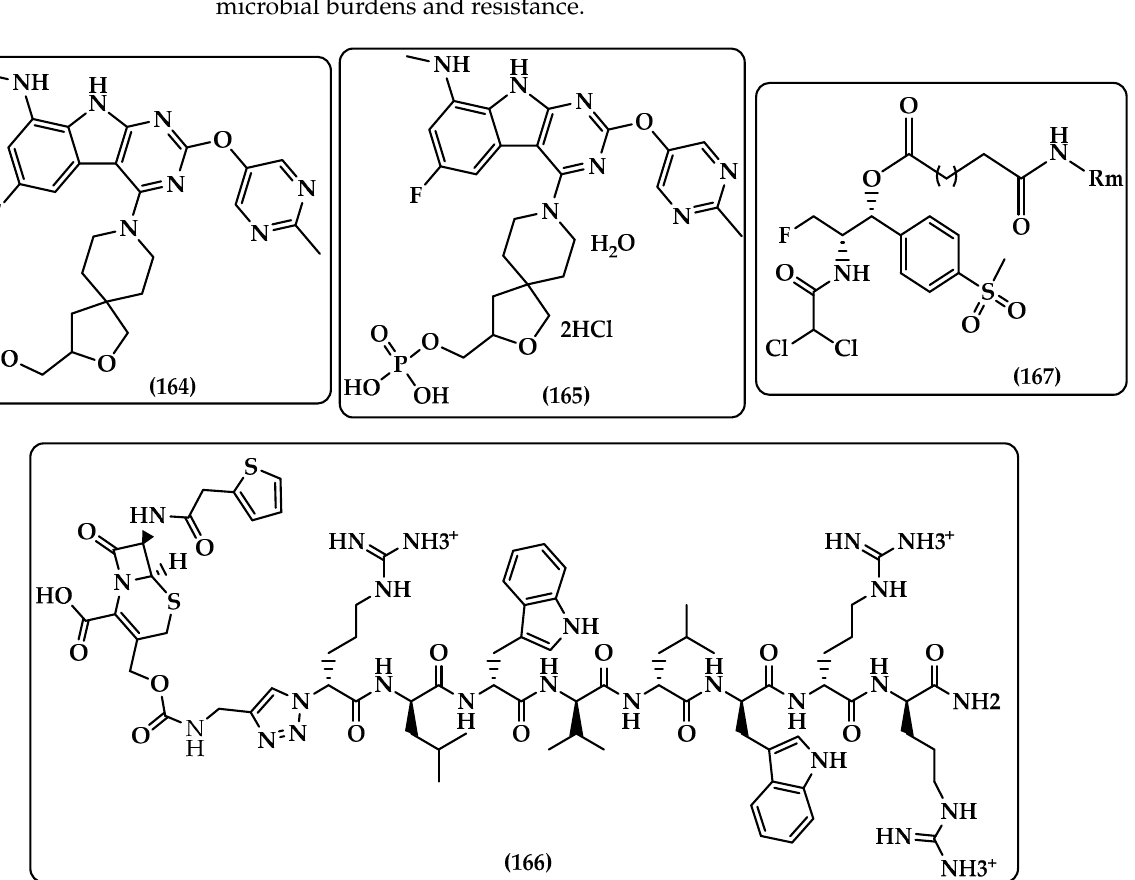
Figure 16. Chemical structure of; JSF-2414 ( 164 ); JSF-2659 ( 165 ); cephalothin-Bac8c ( 166 ); and florfenicol ( 167 ).